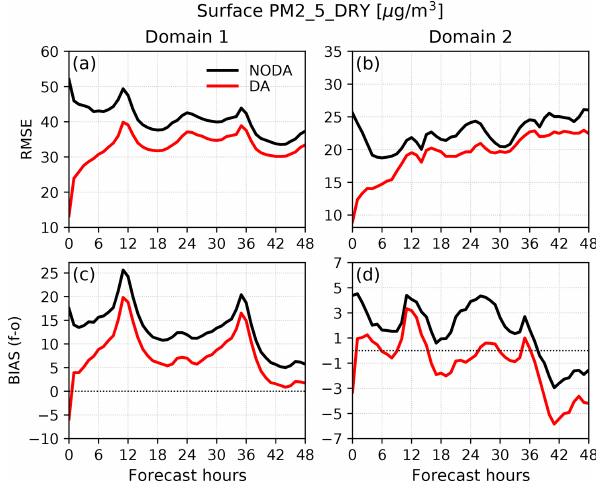
Figure 12. Time series of (a,b) root-mean-square error (RMSE) and (c,d) bias as (forecast minus observation) in surface PM 2 . 5 con- centration of the hourly forecasts from the analysis at 00:00UTC from 7 to 31 May 2016. The left panels (a,c) show the errors of forecasts at 27km resolution verified against 1188 stations over do- main 1, and the right panels (b,d) present the 9km forecast errors with respect to surface PM 2 . 5 observations from 71 independent stations in